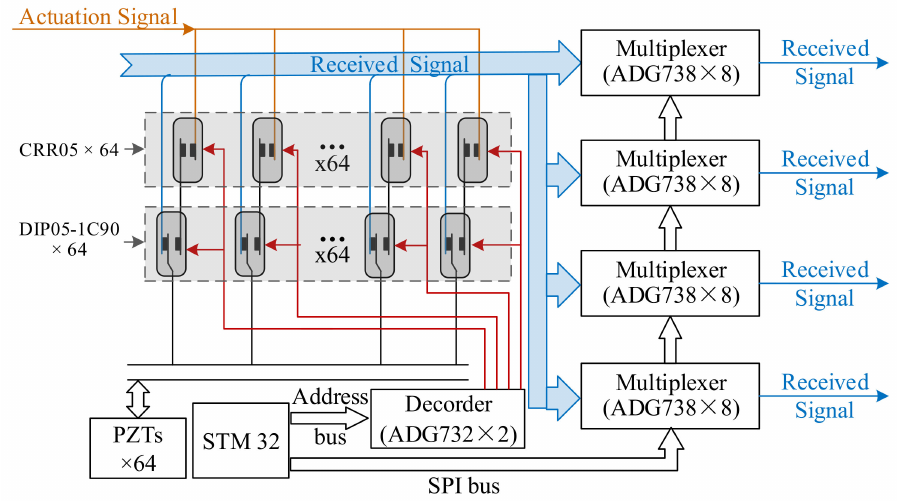
Figure 5. Diagram of matrix switcher